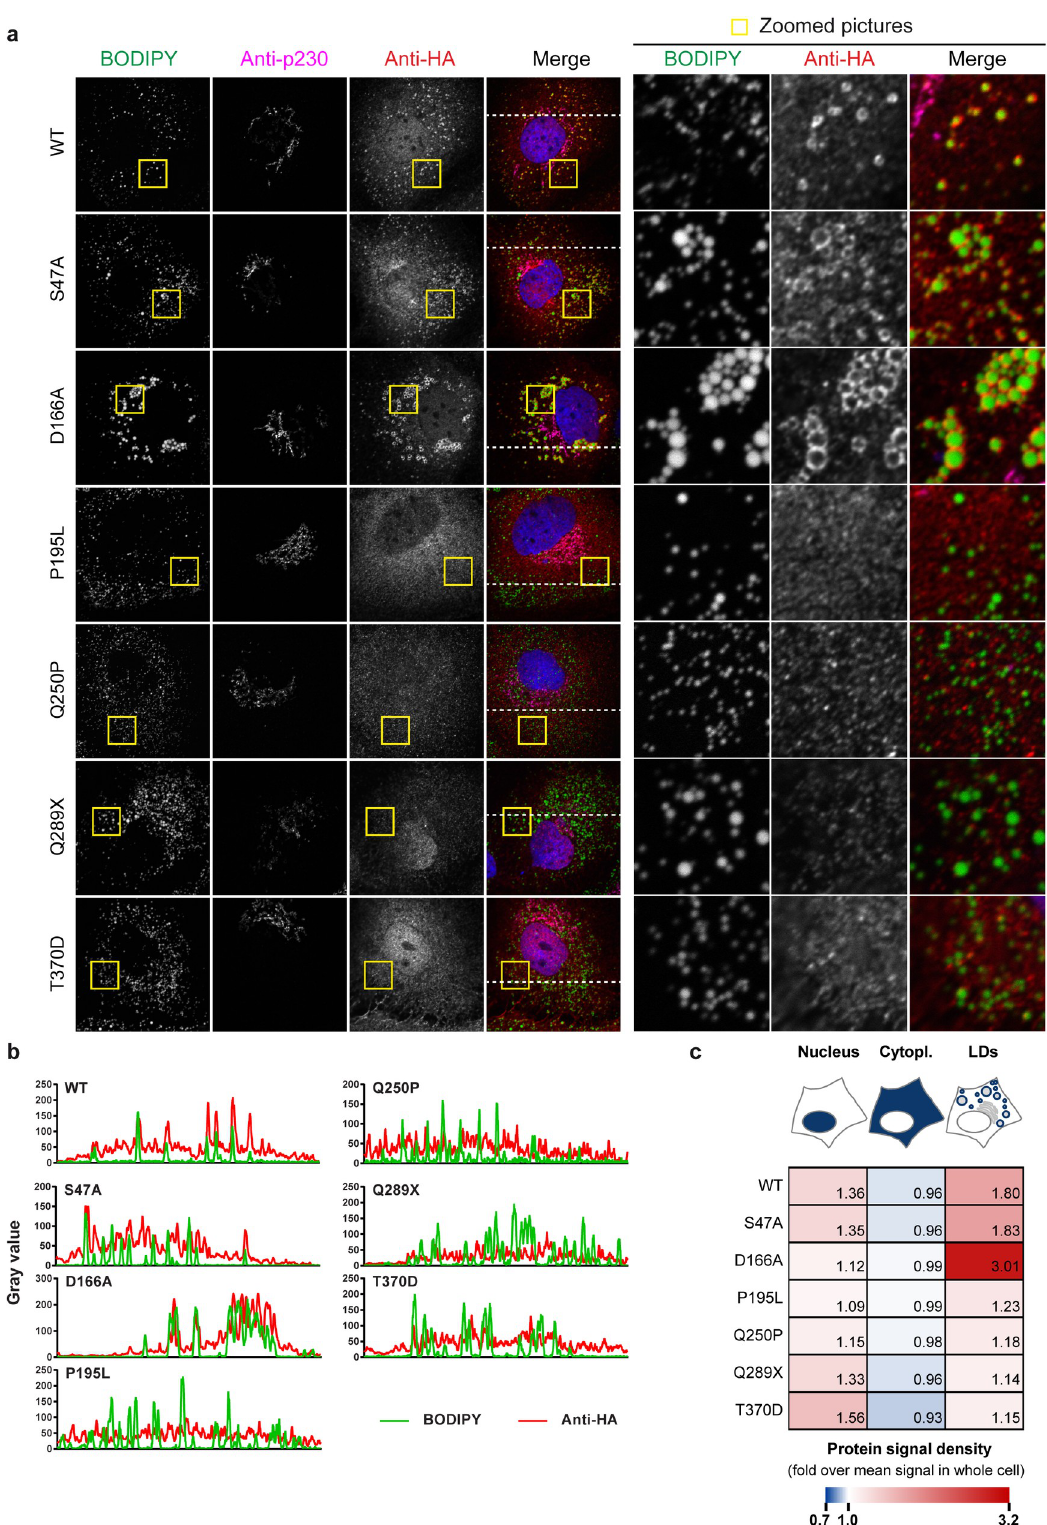
Fig 8. Subcellular localization and lipid droplet association of ATGL variants. ( a ) Immunofluorescence analysis of HA-tagged ATGL localization respectively to the lipid droplets (BODIPY 493/503) and trans -Golgi (p230 marker) in Lunet N hCD81 cells. ( b